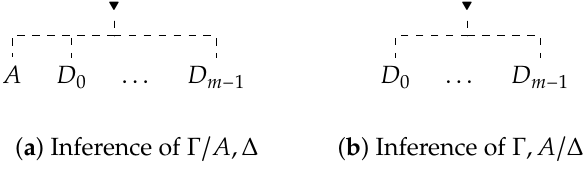
Figure 8. Proof of (T): the premises.